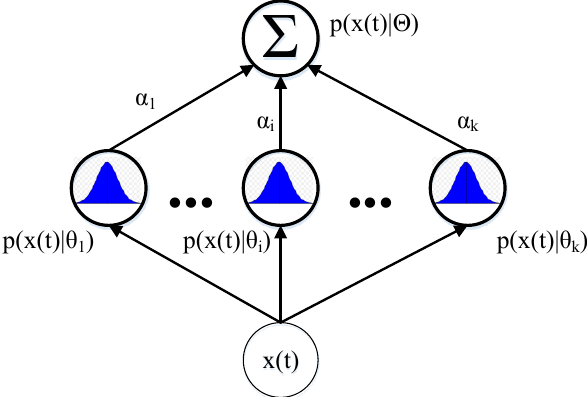
Figure 3. General concept of the Bayesian Framework for flood classification. Figure 4. Structure of a Gaussian mixture